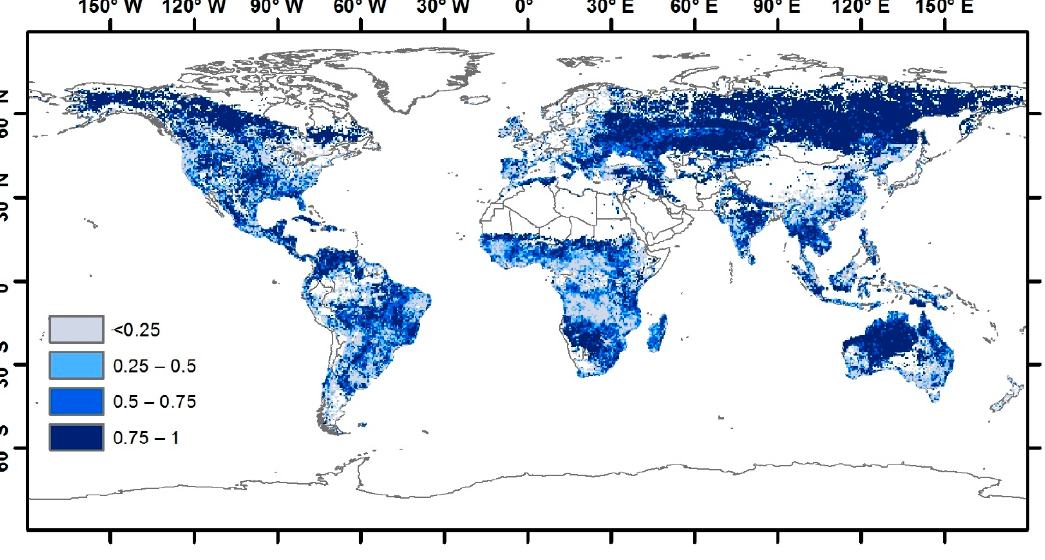
Figure 7. Spatial correlation between the common time series (2001–2018) of both BA datasets.